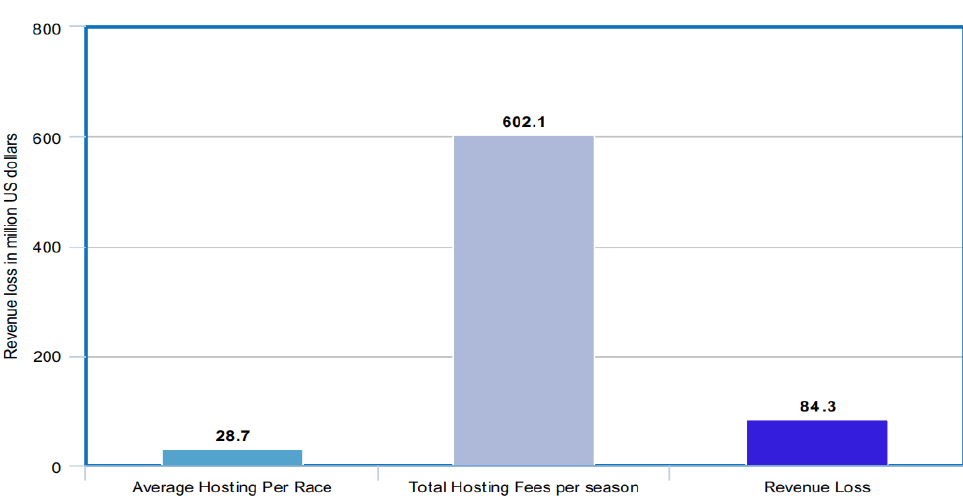
Figure 15. Potential loss of revenue for Formula One due to the COVID-19 outbreak.